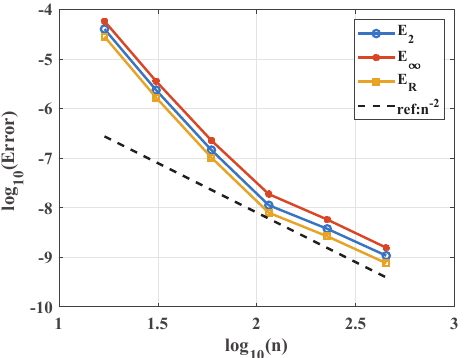
Figure 1. Diagram of degrees of freedom (DoFs) vs. the error between the numerical and analytical solutions in 1D.